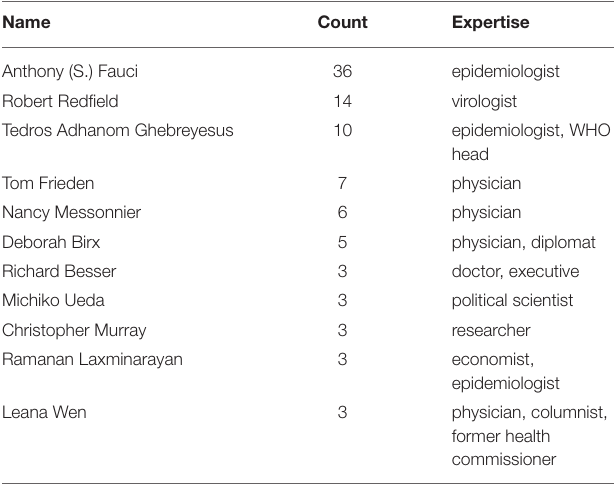
TABLE 5 | Most cited actors in context of COVID-19 after manually filtering out the names of individuals without scientific